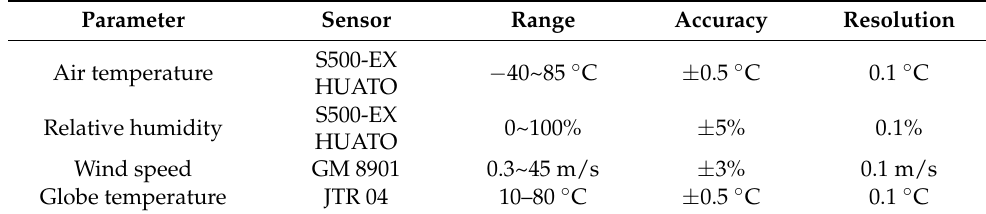
Table 1. Specifications of the sensors used in the field